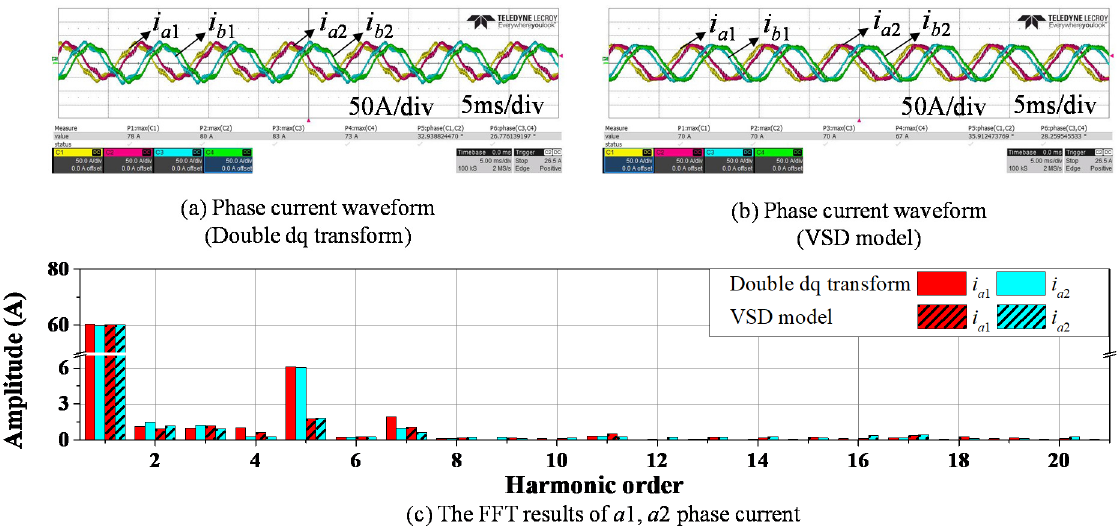
Figure 9. ( a – c ) Experiment results of phase current profile, and FFT analysis when applying to the Double dq transform and VSD model. Figure 10 is the torque profile, and the average torque is the same. The torque ripple is 0.71% for VSD model and 1.75% for double dq transform.